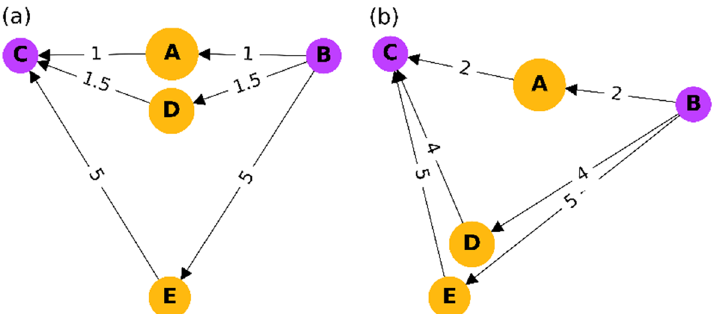
Fig. 1 Toy example for local detour